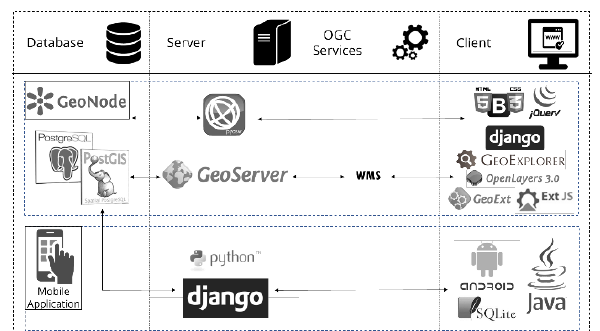
Figure 5. Poli-RISPOSTA system